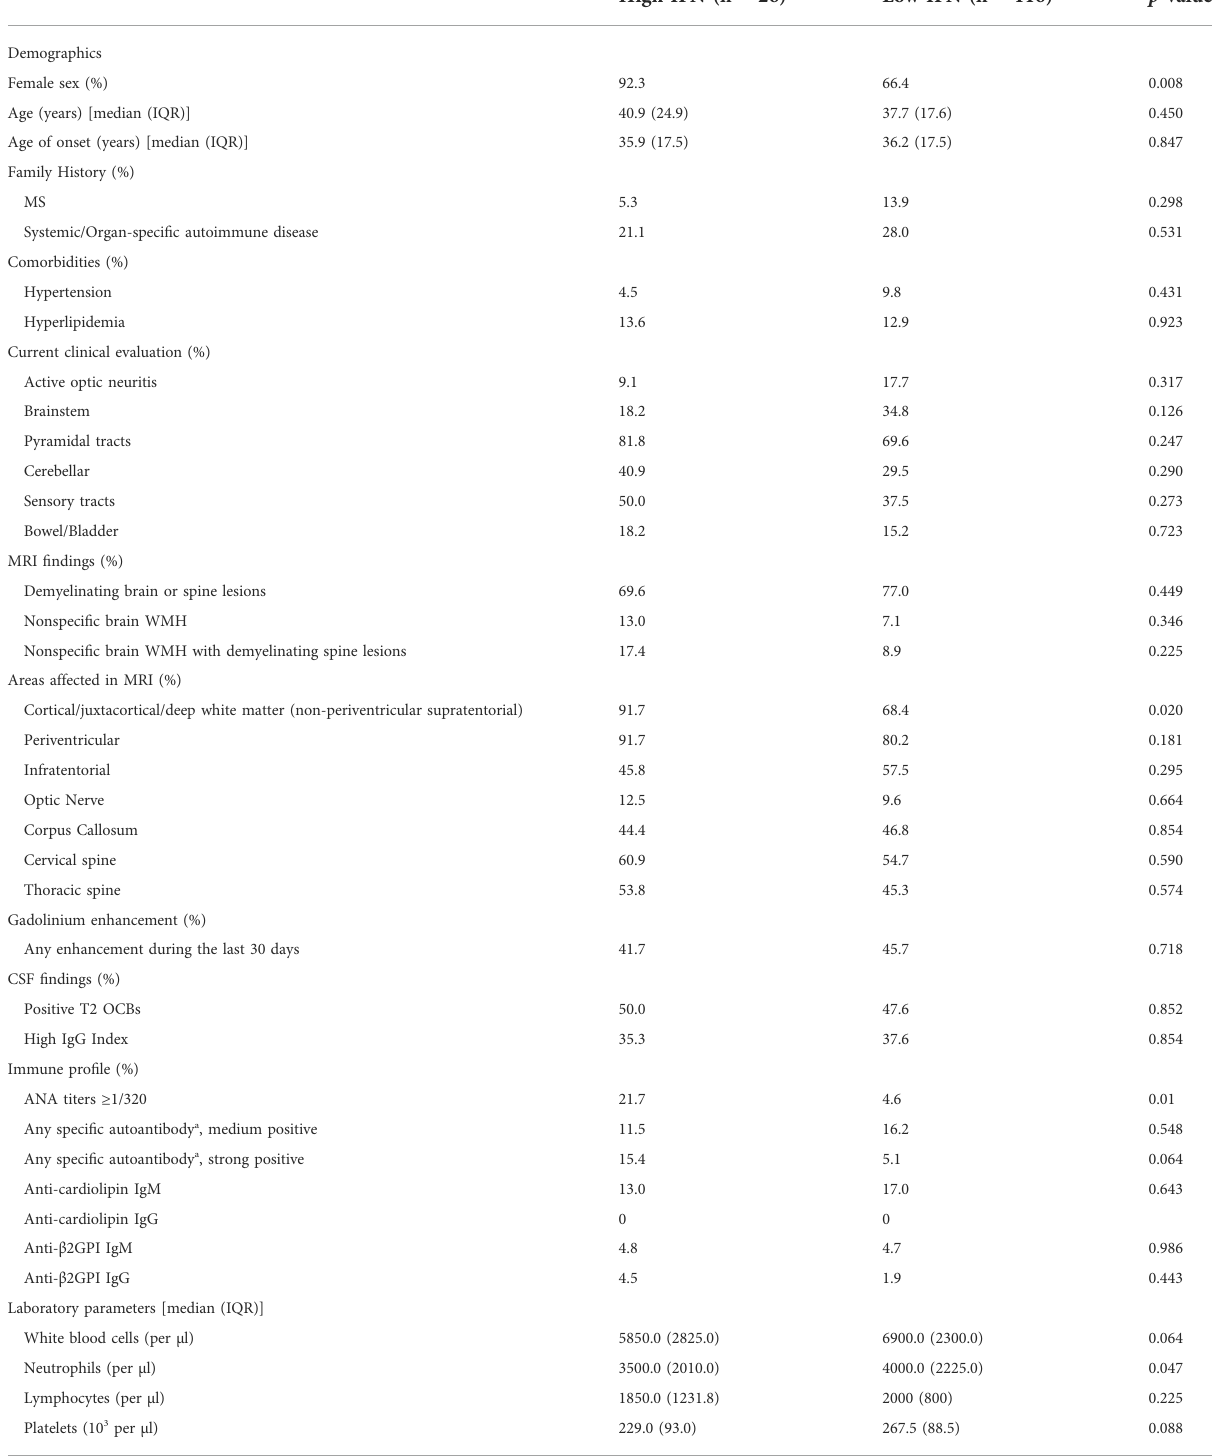
TABLE 4 Clinical, imaging and laboratory features in high vs. low type I IFN groups (See Methods for classi fi cation). High IFN (n = 26) Low IFN (n = 116) p